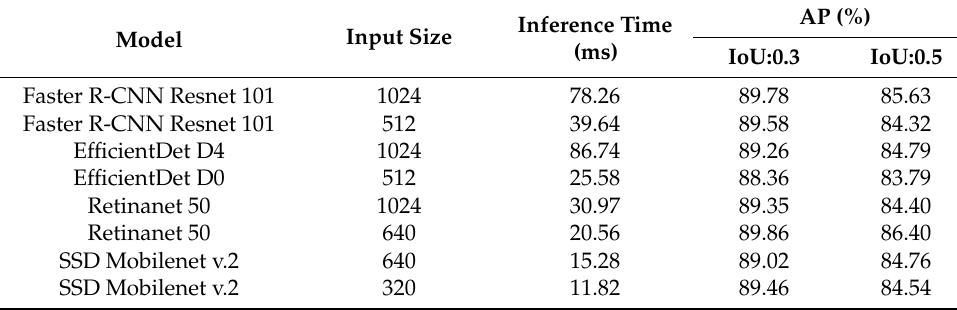
Table 2. Test results of M. thunbergianae detectors (12 × 8 cropping condition).